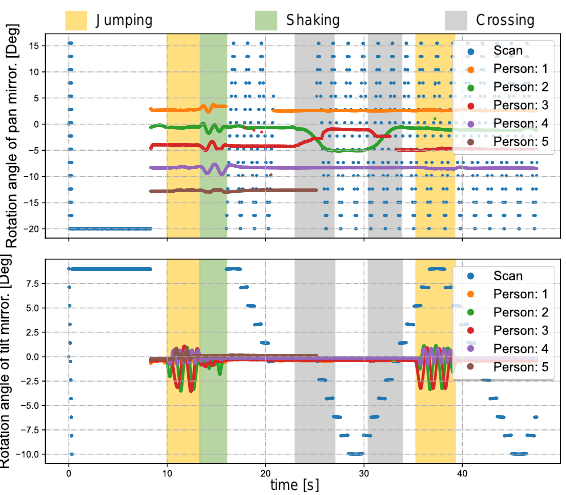
Figure 18. Pan and tilt angles of the galvanometer-based reflective PTZ camera when scanning and tracking multiple persons.